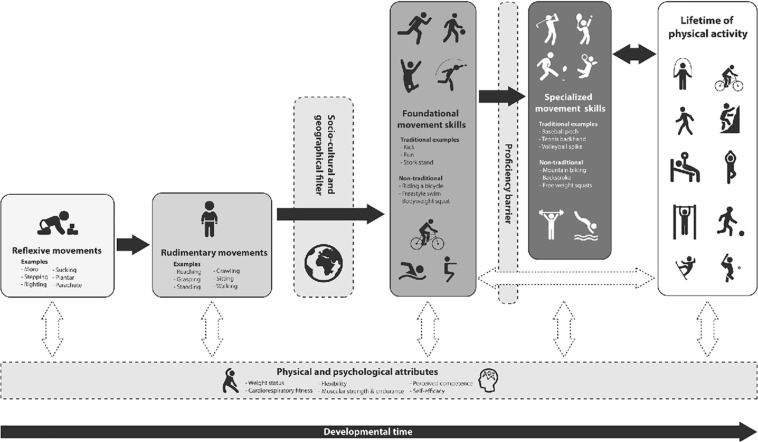
Development of foundational movement skills supporting physical activity across the lifespan (Hulteen et al., 2018).